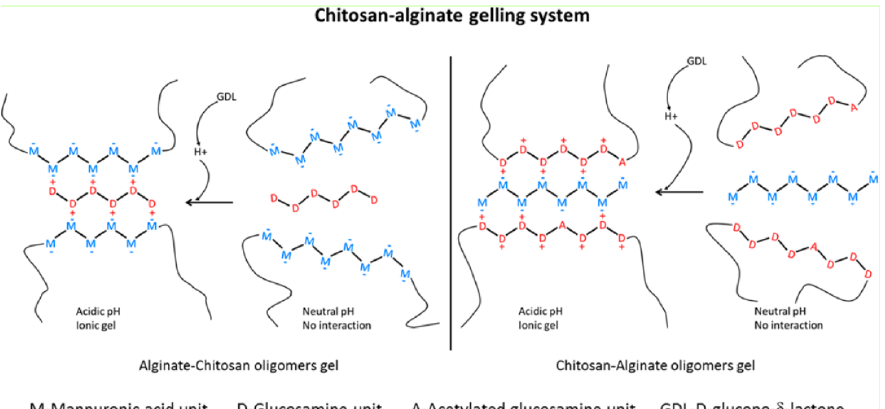
Figure 4. Gelling concept for synthetizing alginate-chitosan oligomers ( left ) and chitosan-alginate oligomers ( right ) gels via controlled internal gelation. Adapted with permission from [14], Copyright 2013 American Chemical Society.